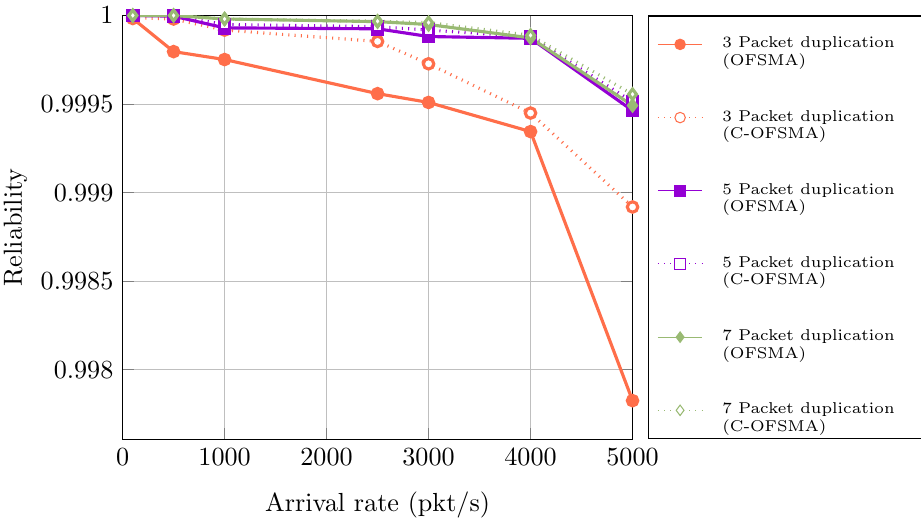
Figure 7. Determine reliability using 90 channels for both OFSMA and C-OFSMA